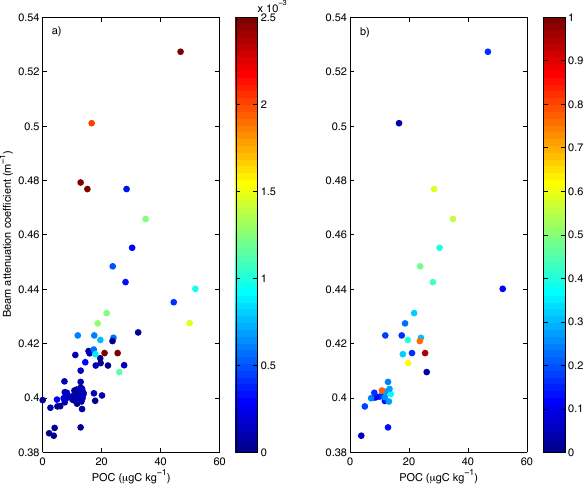
Fig. 16. As in Fig. 9 but for correlations between attenuation and POC. Linear relations and R 2 values are listed in Table 2. Note that the scales are different in each figure.